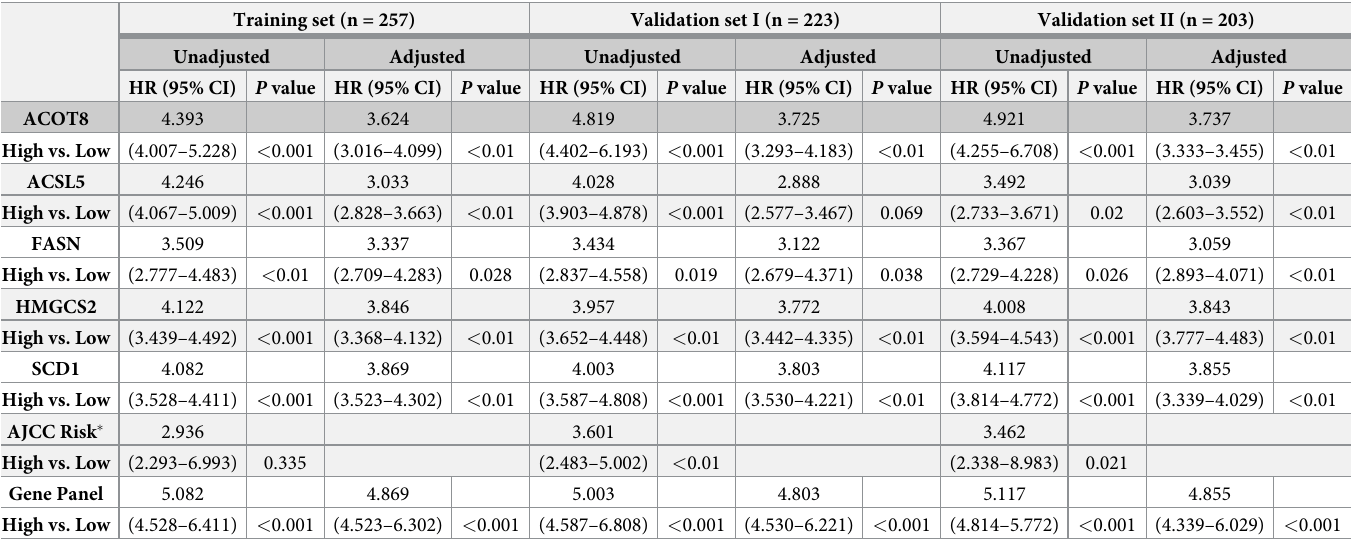
Table 5. Univariate and multivariate cox regression analysis of overall survival of lipogenic genes signature as individual biomarkers and in the form of a panel in CRC patients. Training set (n =